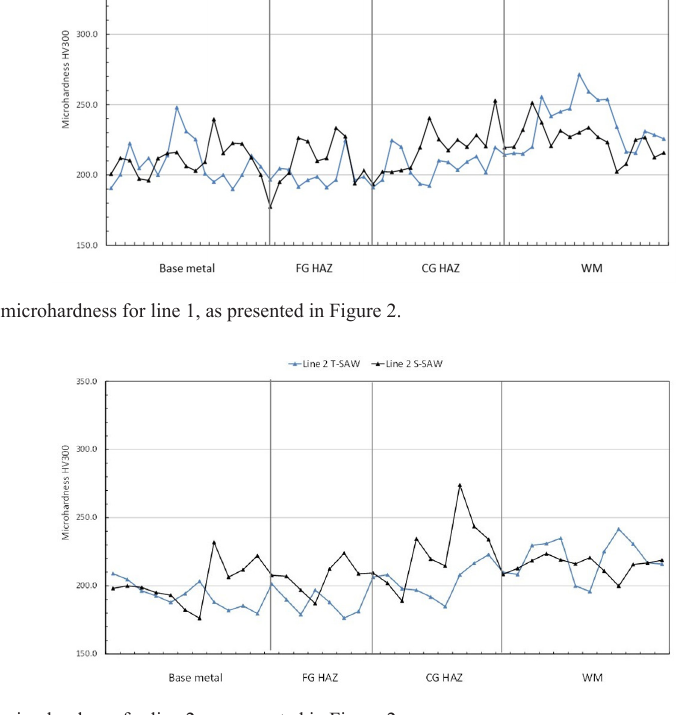
Figure 14: Results of microhardness for line 2, as presented in Figure 2.